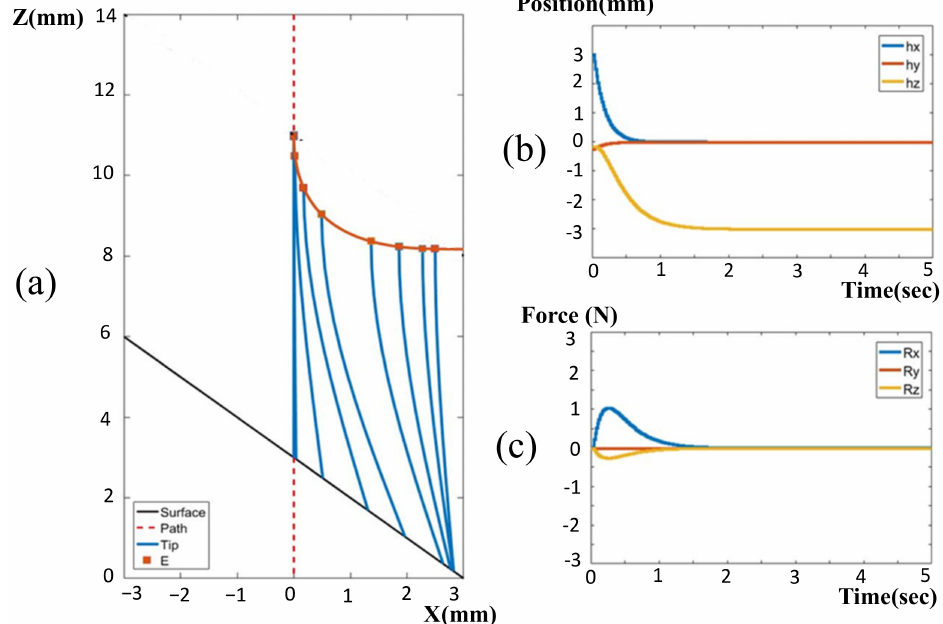
Figure 7. Contact compliance adjustment-based visual servo: ( a ) tool tracking trajectory in X-Z plane; ( b ) positioning errors in X-, Y- and Z-directions; ( c ) contact forces in X-, Y- and